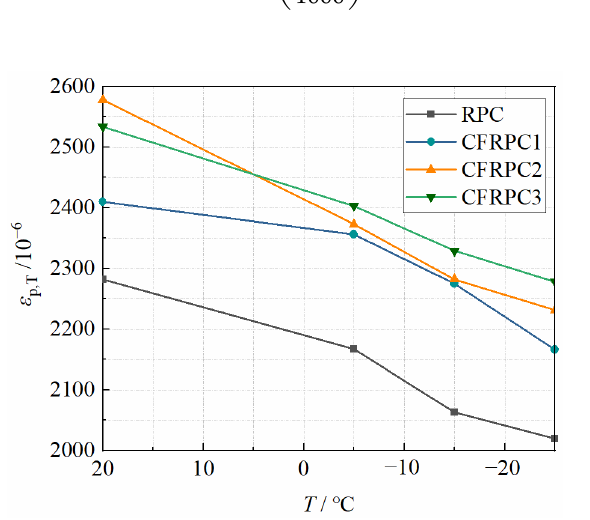
Figure 23. Relationship ε p,T vs. T.